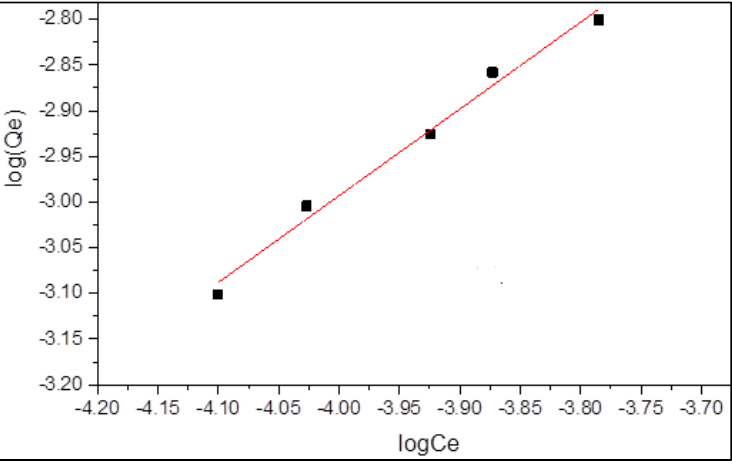
Figure 7. Freundlich adsorption isotherm model of the Basic Red 5 on the